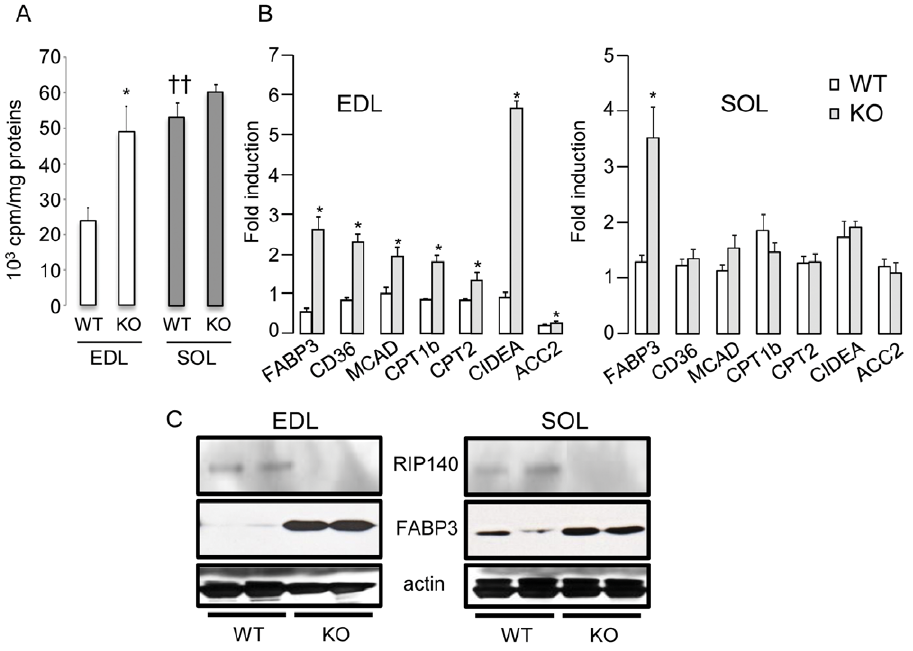
Figure 2. Absence of RIP140 increases fatty acid utilization in the EDL. (A) b -oxidation rate, normalized to proteins, monitored in EDL and soleus (SOL) isolated from RIP140-null (KO) and WT mice (n=4). Data are expressed as mean 6 SEM. *p , 0.05, WT vs KO; {{ p , 0.01, WT soleus vs WT EDL. (B) Real-time RT-PCR analysis of genes implicated in fatty acid binding and transport in EDL and soleus (SOL) of RIP140-null (KO) and WT mice. Data are comparable between histograms for the same gene and expressed as mean 6 SEM. *p , 0.05, WT vs KO. (C) Analysis of RIP140, FABP3 and actin expression in RIP140-null (KO) and WT EDL and soleus (SOL) by western blot.